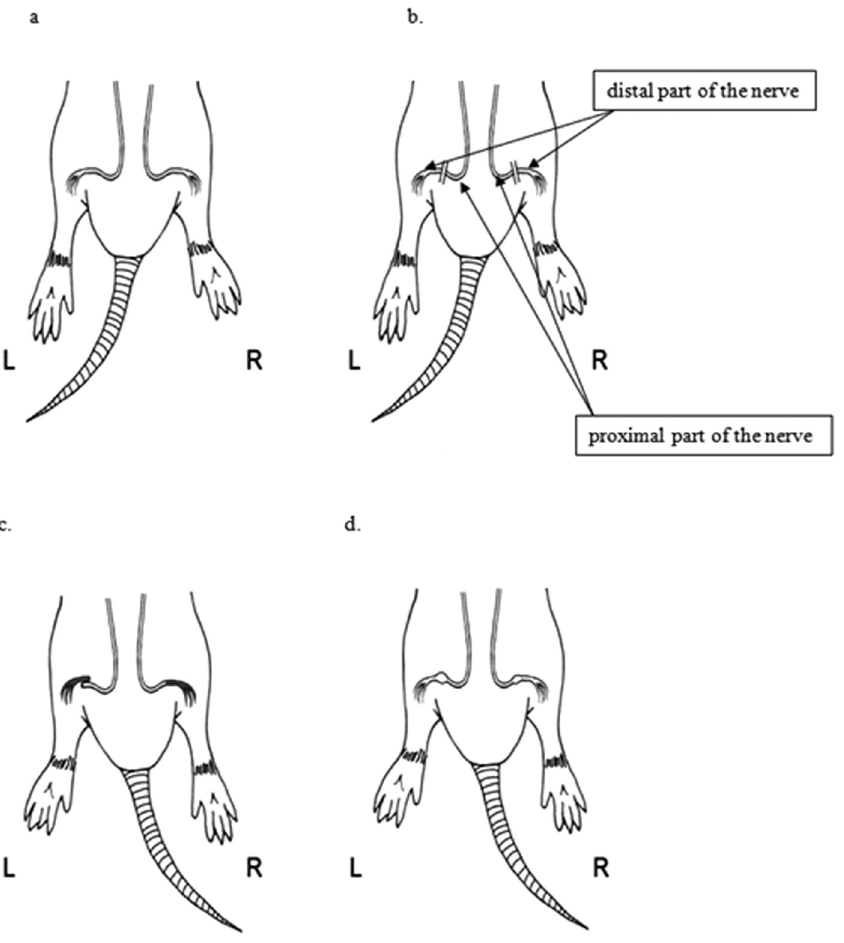
Figure 1: The schematic representation of ( a ) exposure of sciatic nerves, ( b ) transecting the nerves, ( c ) anastomosis L ( left side ) side - to - side, R ( right side ) end - to - end, and ( d ) follow - up after 4